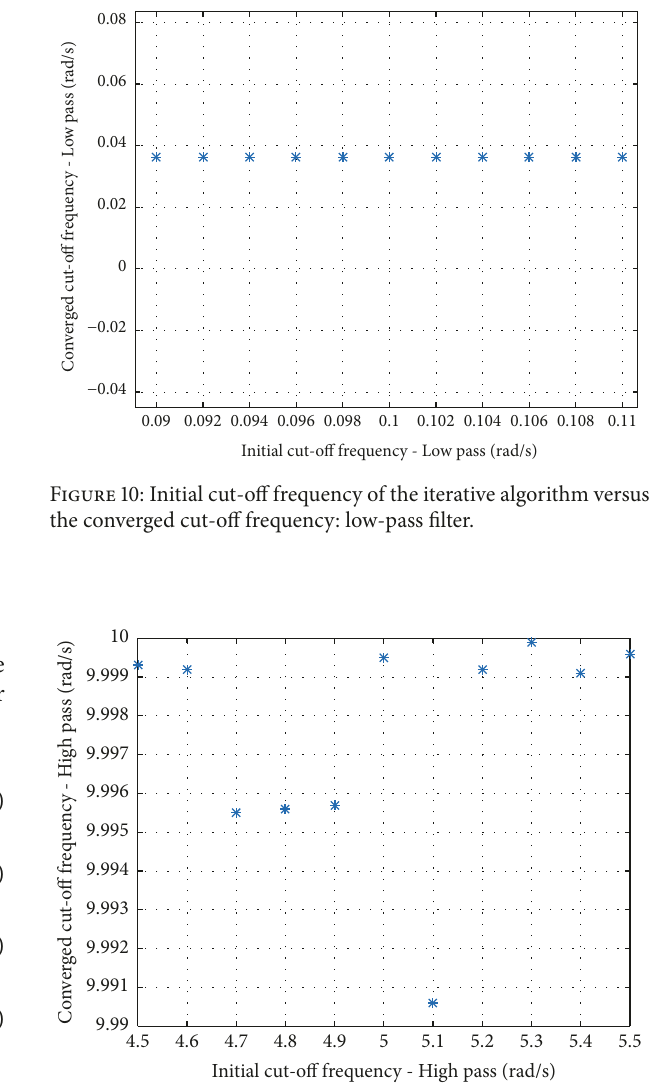
Figure 11: Initial cut-off frequency of the iterative algorithm versus the converged cut-off frequency: high-pass filter.